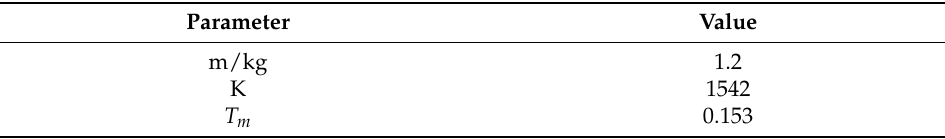
Table 4. Parameters of the brushless